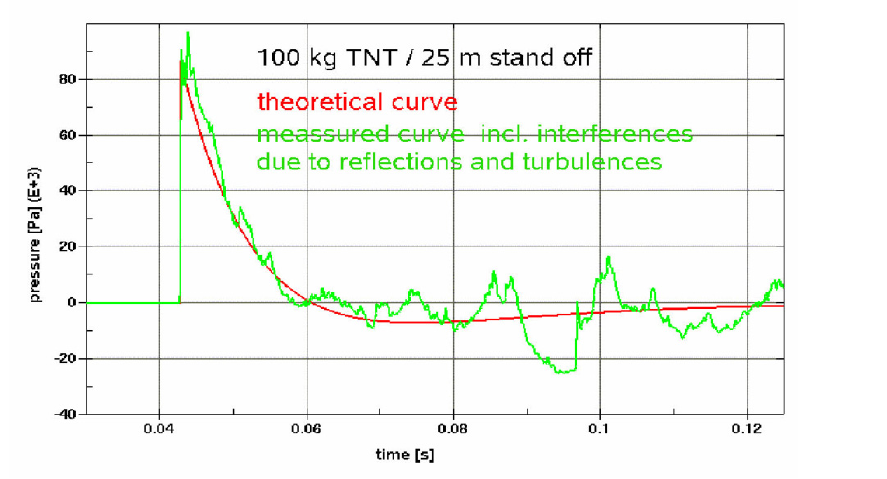
Figure 8. Measured and computed pressure-time-curve (measurement source: Bollrath Pro FORCE)